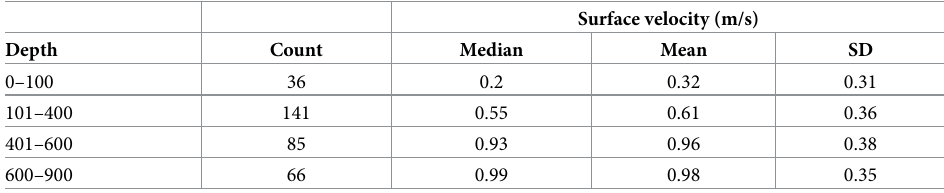
Table 3. Summary statistics of drifters at different water depth